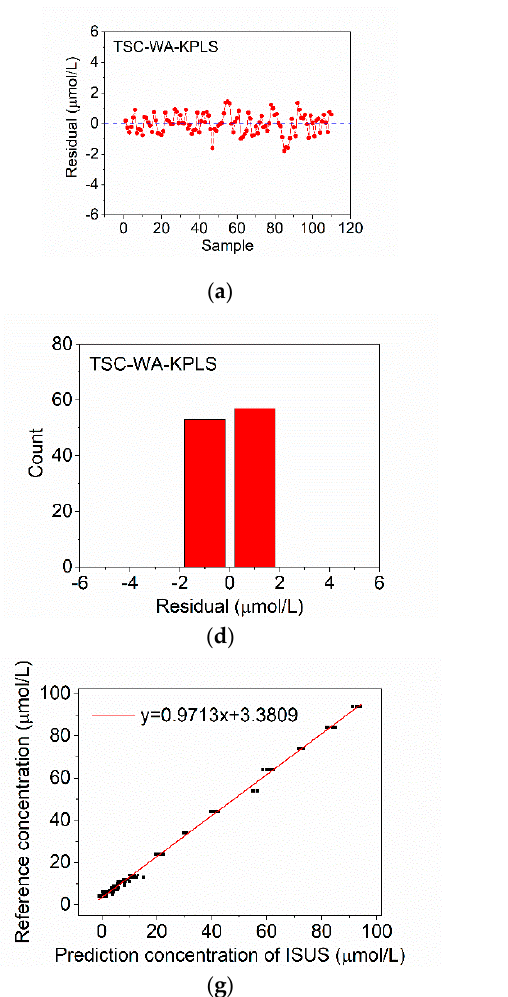
Figure 8. Prediction results of seawater samples from Aoshan Bay. ( a ) Residual of temperature and salinity correction weighted average kernel partial least squares (TSC-WA-KPLS) algorithm; ( b ) residual of TSC-multiple linear regression (MLR) algorithm; ( c ) residual of ISUS algorithm after linear calculation; ( d ) frequency count of TSC-WA-KPLS; ( e ) frequency count of TSC-MLR; ( f ) frequency count of ISUS model after linear calculation; ( g ) linear correction for ISUS algo- rithm.